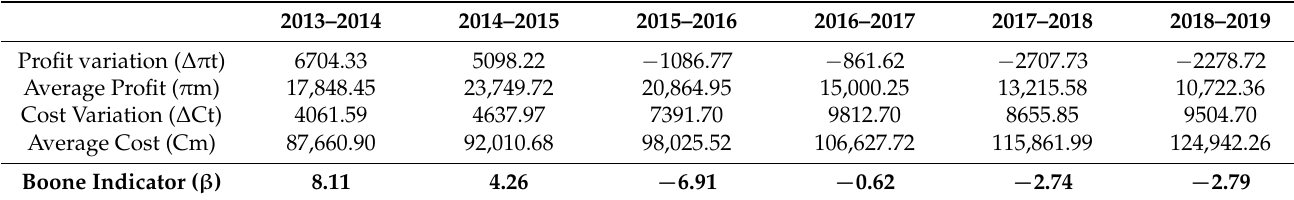
Table 6. Boone indicator for E.G. financial subsector